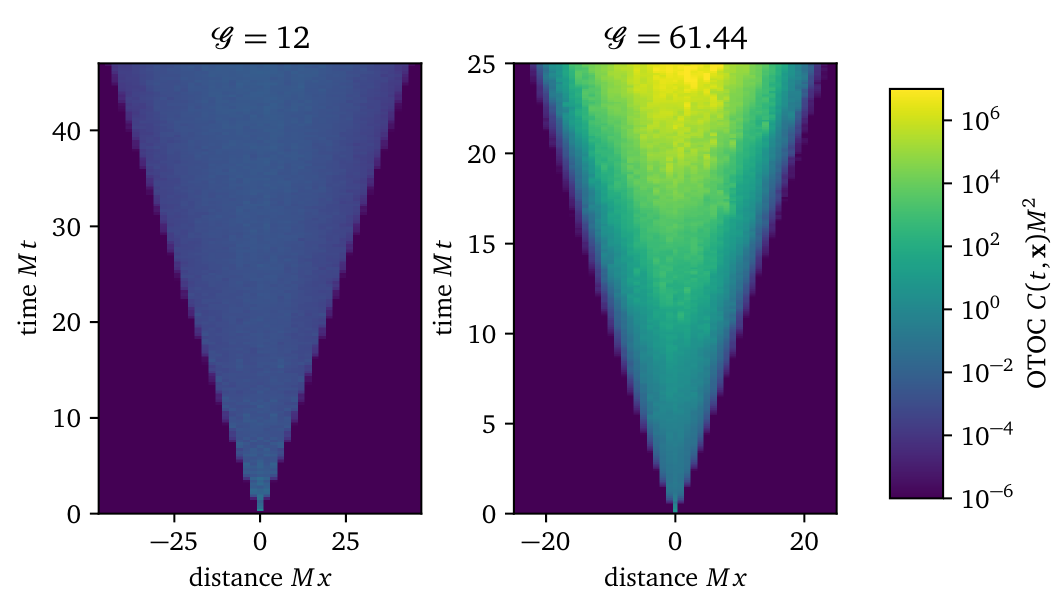
Figure 2: Ballistic spreading of OTOC. Cut of the OTOC along one axis. For all values of G (left: G = 12,, right: G = 61.44) studied in this work, we find ballistic spreading of the OTOC. However, both the butterfly velocity and the Lyapunov ex- ponent associated with the exponential growth within the lightcone shows a strong dependence on G . Due to the ambiguity of the color scale, it is not possible to read off the butterfly velocity directly from this plot. For a detailed discussion see Sec.